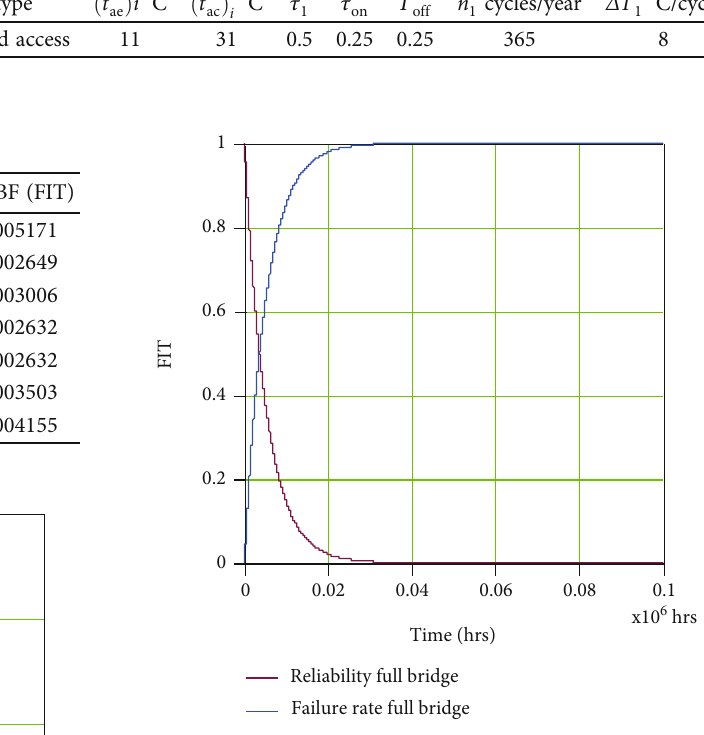
Figure 13: Representation of the probability of failure of the full- bridge